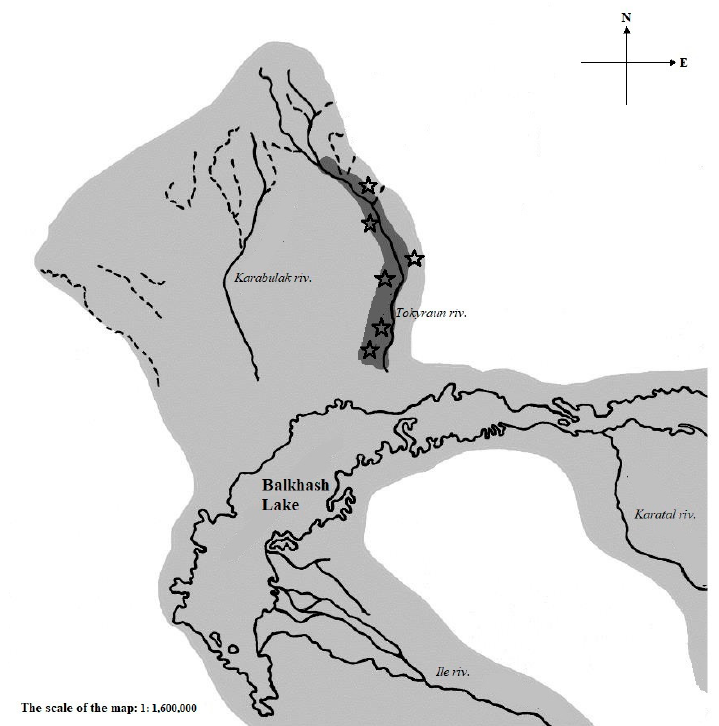
Figure 1. Sampling sites of Balkhash marinka in Tokyrauyn River (open pentagram represents the location of sampling sites).